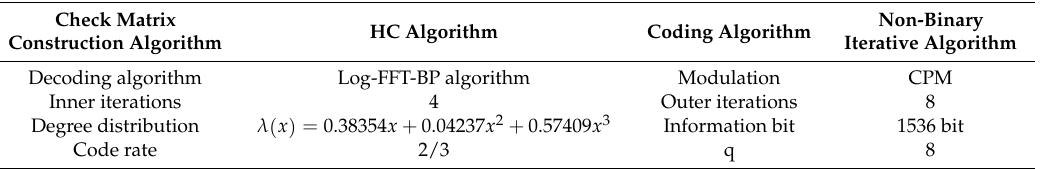
Table 3. The parameters of the non-binary LDPC-CPM system.